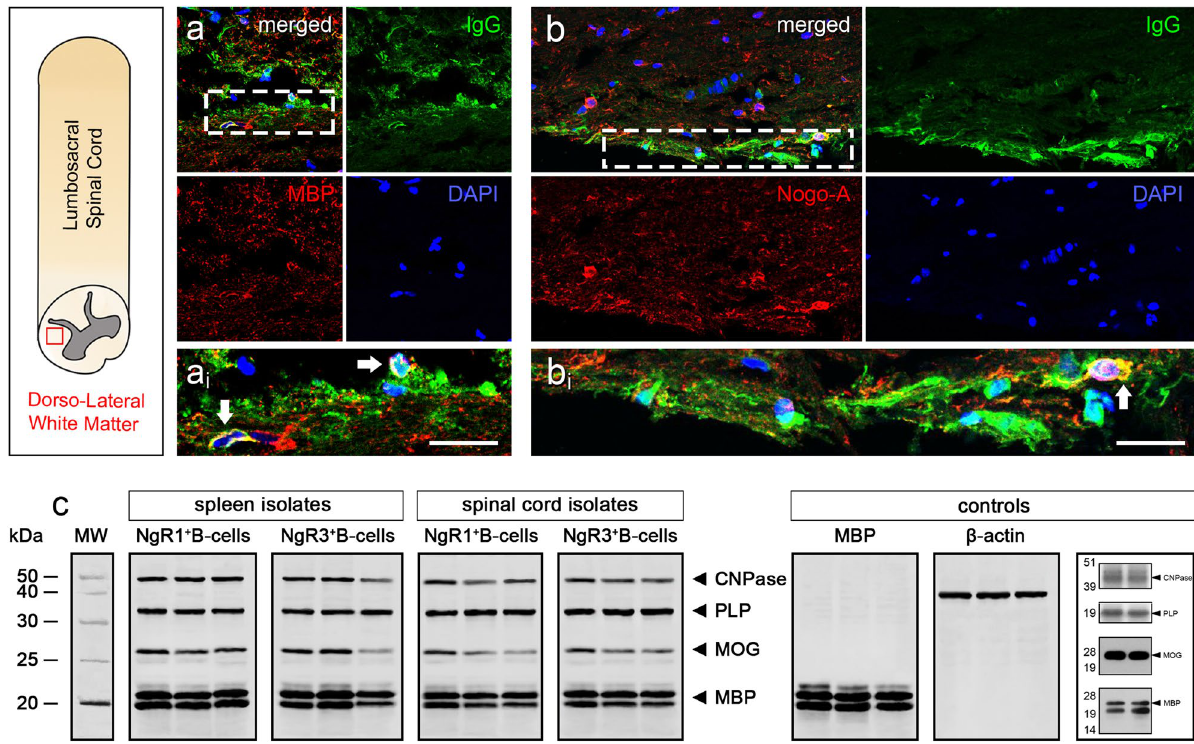
Figure 5. Secreted immunoglobulin responses by BAFF-responsive NgR1 + and NgR3 + B-cells are directed against CNS myelin. ( a , b ) Double immunofluorescence labeling of NgR1 + and NgR3 + B-cell-secreted IgG (green) co-localized with MBP and Nogo-A, respectively (red), within adjacent spinal cord sections of EAE mice. DAPI (blue) stained cell nuclei. a i : inset of hatched box in a, b i : inset of hatched box in b. White arrow indicates co-localization. Scale = 5 μm. ( c ) Western Immunoblot analysis of secreted IgG in the supernatant from isolated cells. Purified myelin from lumbar spinal cord of ngr1 + / + and ngr1 −/− mice were differentiated on a 4–12% Bis–Tris gel. IgG presented in the supernatant could directly bind to the major myelin proteins MBP, MOG, PLP and CNPase, annotated in the gel, respectively. The three lanes per box are replicates. No immunoreactive bands were detected when a commercial IgG antibody was utilized as a